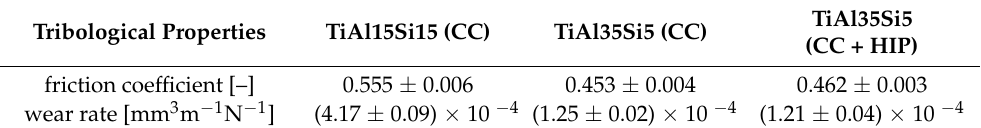
Table 2. Tribological properties of tested alloys.